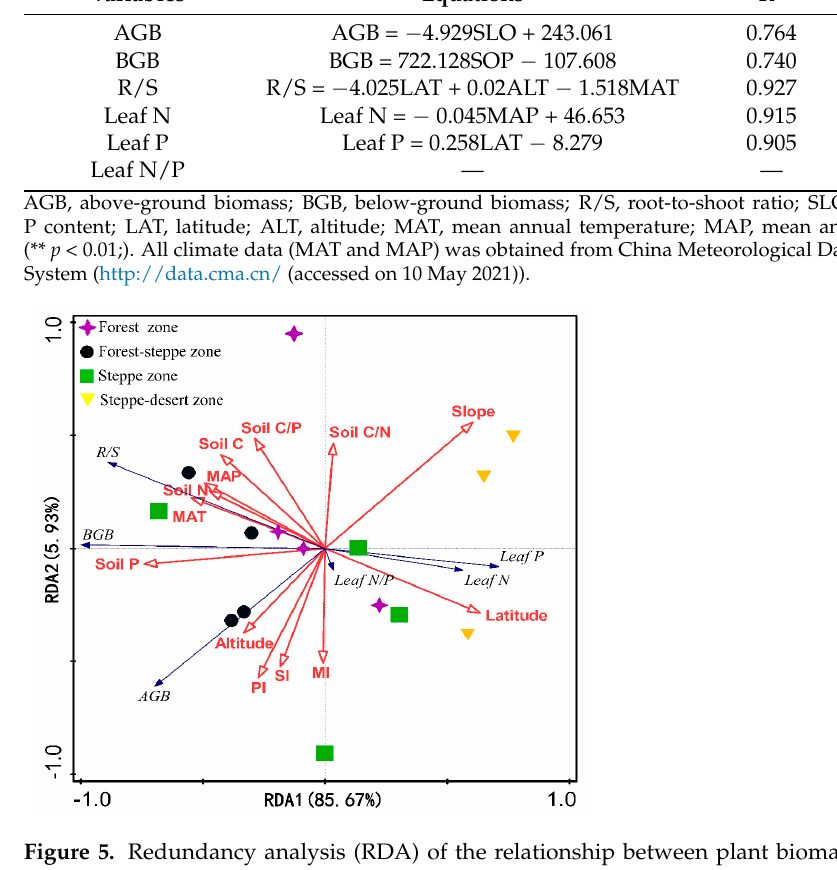
Figure 5. Redundancy analysis (RDA) of the relationship between plant biomass, leaf N and P stoichiometry and environmental driving factors in different vegetation zones. Note: AGB, above-ground biomass; BGB, below-ground biomass; R/S: root-to-shoot ratio; Leaf N: leaf nitrogen content; Leaf P: leaf phosphorus content; Leaf N/P: leaf nitrogen/ phosphorus ratios; Soil C: soil organic carbon; Soil N: soil total nitrogen; Soil P: soil total phosphorus; Soil C/N: soil carbon/nitrogen ratios; Soil C/P: soil carbon/ phosphorus ratios; Soil N/P: soil nitrogen/ phosphorus; MAP: mean annual precipitation; MAT: mean annual temperature; SI: Shannon–Wiener diversity index; MI: Margalef richness index; PI: Pielou evenness index. All climate data (MAT and MAP) was obtained from China Meteorological Data Sharing Service System (http://data.cma.cn/ (accessed on 10 May